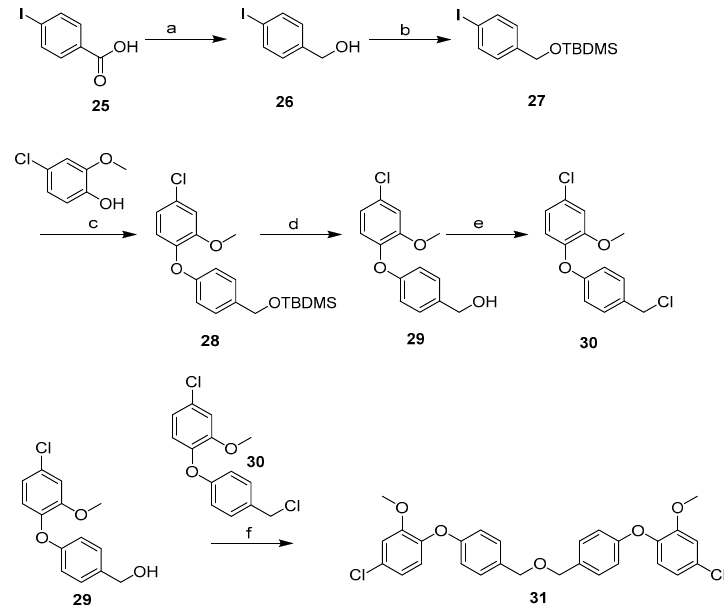
Scheme 5. Synthesis of the di-triclosan dimethyl ether 31 . Reagents and conditions : ( a ) BH 3 , THF, r.t., overnight, 91%; ( b ) TBDMSCl, imidazole, DCM, r.t, overnight, 94% ( c ) CuI, Cs 2 CO 3 , naphthoic acid, toluene, r.t., 3 days, 41%; ( d ) TBAF, THF, 0 °C to r.t., 4.5 h, 79%; ( e ) MsCl, Et 3 N, 0 °C to r.t., 4